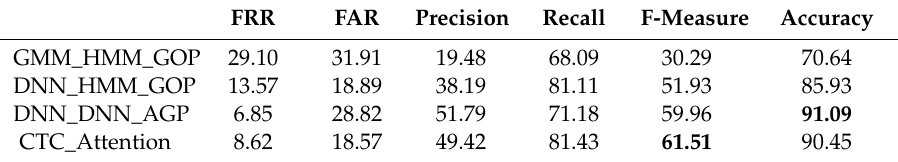
Table 11. Performance of APED systems for initial g.